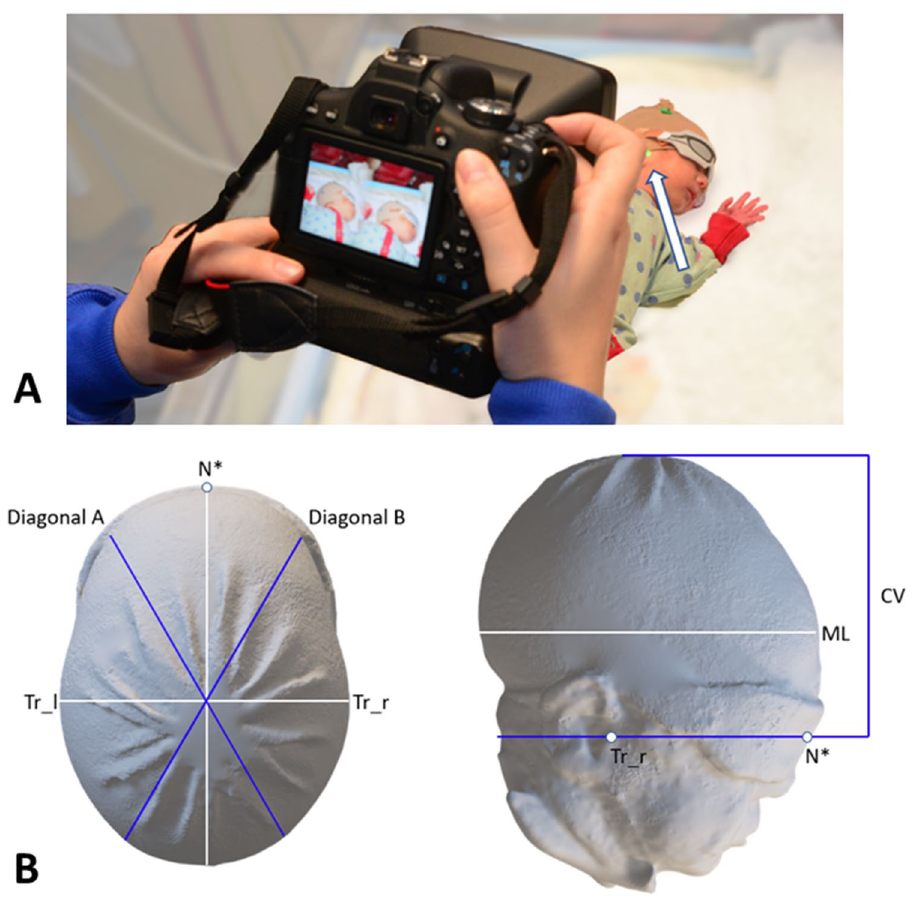
Figure 1. ( A ) Image acquisition. Infant wearing a nylon cap and eye protectors. Arrow points to two merged green light spots that indicate the correct distance (1 m) between the H1 portable camera and the infant’s head. ( B ) Display of the planes and areas for measurements of the infants’ heads. Due to the eye protectors, the anatomic landmark “nasion” is modified and was referred to as nasion* (N*). The nasion*-tragus plane is a free sagittal plane through the nasion*, the left and right tragus (Tr_l/r), respectively. The head level with the maximum anterior–posterior expansion of the head is defined as the measurement level (ML). Head circumference (HC; cm) is the head perimeter around the ML. Cranial volume (CV; m 3 ) represents the total head volume cranial to the sagittal plane. Transversal view (( B ) left) and lateral view (( B ) right). The cranial index (CI; %) is the proportion of head width to length at measurement level (ML): CI = headwidth headlenght × 100. The cranial vault asymmetry index (CVAI; %) is the difference between the longest (diagonal A) and shortest 30° diagonal (diagonal B) diameter radiating from the midsagittal plane at ML: CVAI = diagonalA